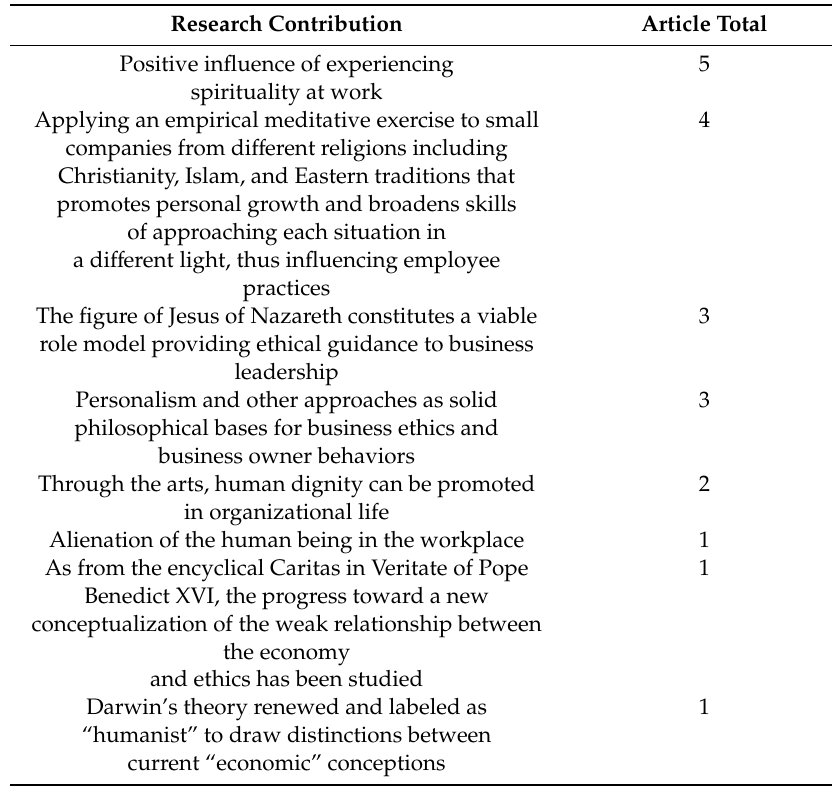
Table 2. Research